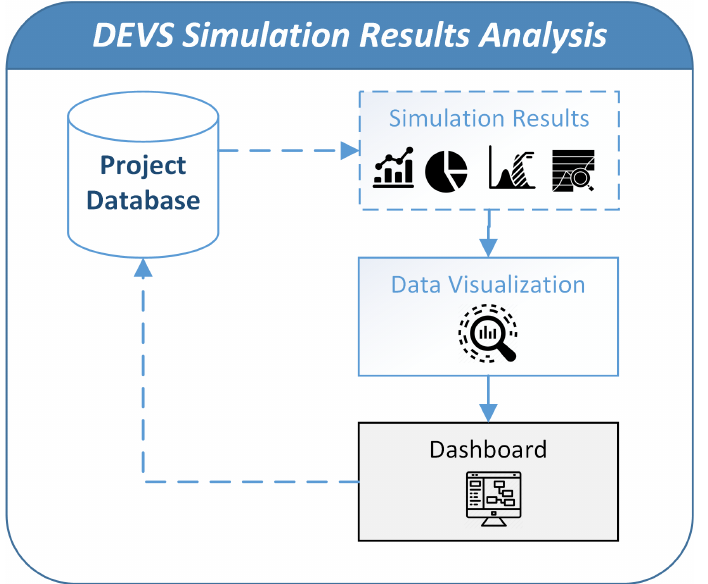
Figure 4. Process of analyzing simulation results stored in the database to generate analysis tables, which then allow the developer to implement web interfaces. The data visualization phase can be performed using artificial intelligence